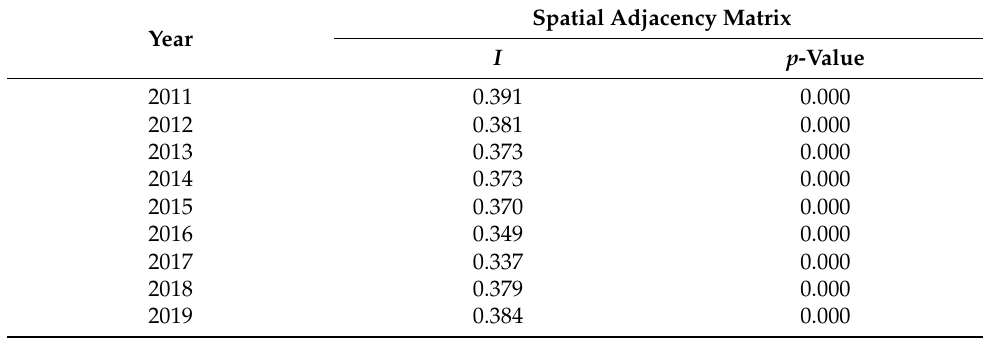
Table 4. Global spatial correlation of green